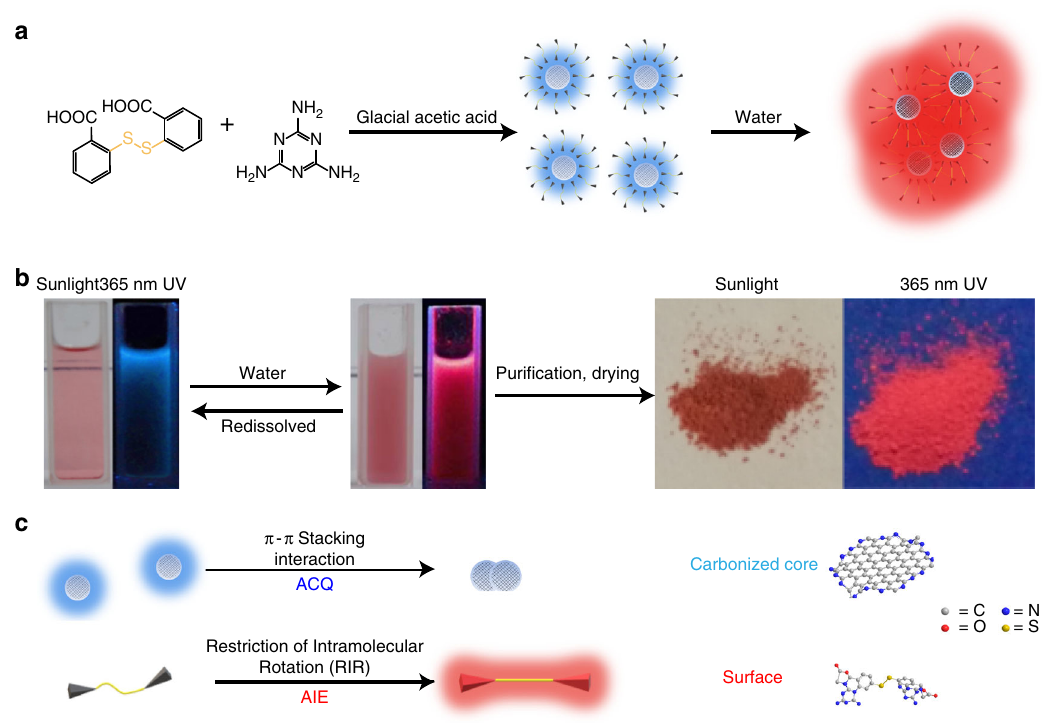
Fig. 1 H-CDs ’ formation, structure, fl uorescence and appearance in different state. a Formation of H-CD monomers and their aggregates (the disul fi de bond in dithiosalicylic acid molecular is highlighted with yellow). b Photographs of the H-CDs ’ two-switch-mode luminescence principle. c Fluorescence principle and proposed structure of H-CD ’ s core and surface (the colors of glowing edges represent the color of their fl uorescence). H-CD, hydrophobic carbon